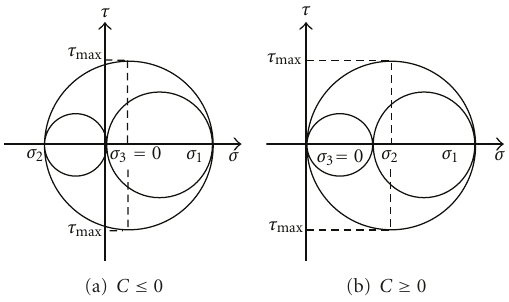
Figure 1: Stress state in copper depicted by Mohr’s stress circle.